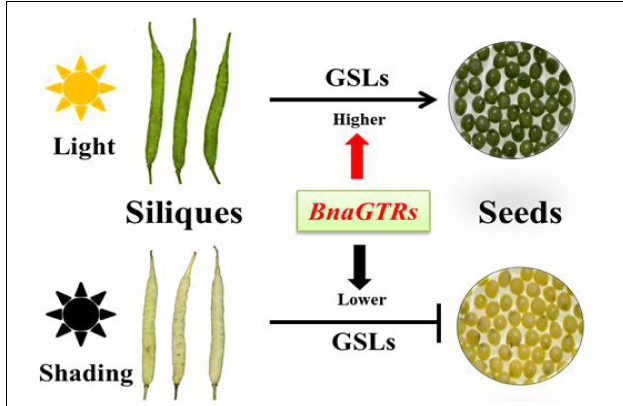
FIGURE 6 | Hypothetical regulatory network of GSLs accumulation and transportation in siliques and seeds of Brassica napus ( B. napus) .